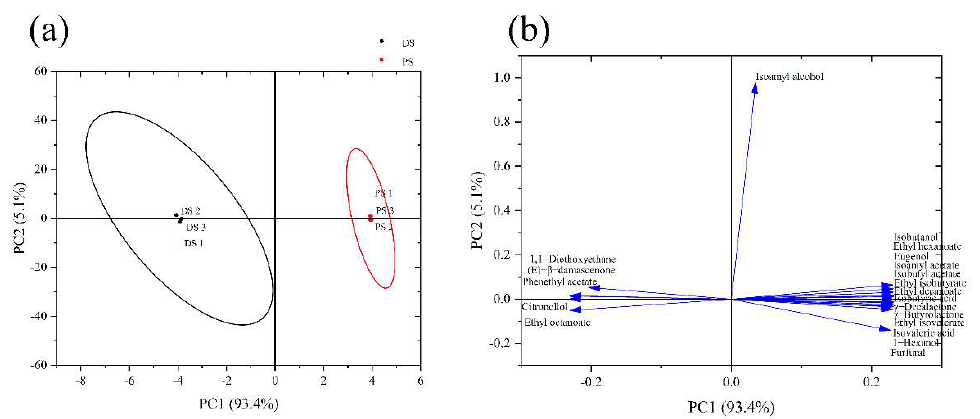
Figure 4. PCA analysis of DS and PS according to the concentrations of the key aroma compounds. ( a ) Score plot of principal component analysis for two peach spirits. ( b ) Loadings plot of principal component analysis for two peach spirits.